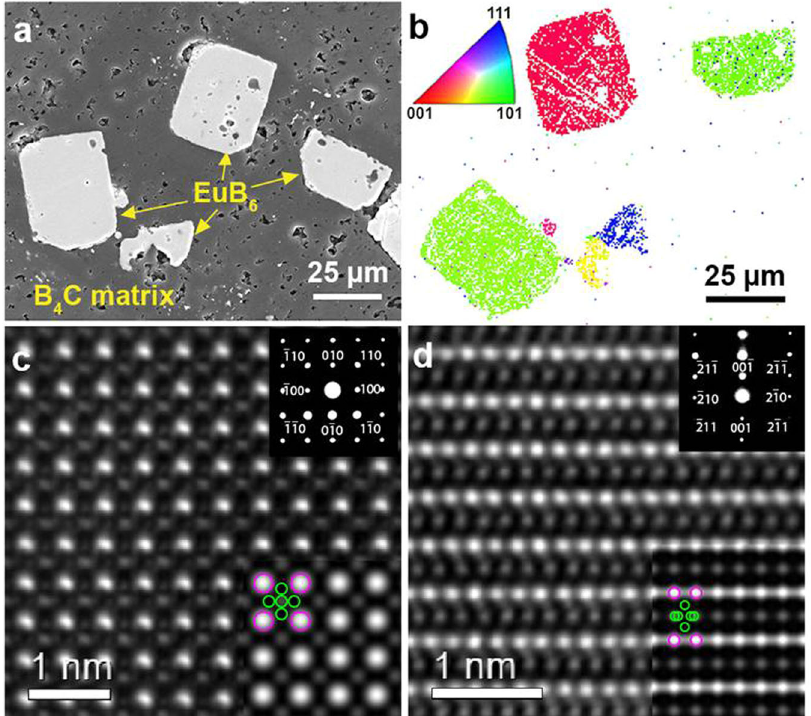
Fig. 1 Electron microscopy characterization of as-synthesized EuB 6 . a Secondary electron SEM image shows microstructure of EuB 6 -B 4 C composite. b Corresponding EBSD pattern of EuB 6 phase. c and d High-resolution TEM images of EuB 6 along [100] and [120] zone axes, respectively. Simulated HRTEM images are superimposed on the rightmost lower corner of the images. The boron (B) and europium (Eu) atoms are represented by open circles with green and magenta colors, respectively. The indexed diffraction patterns along same zone axes are also shown at the rightmost upper corner of the images.